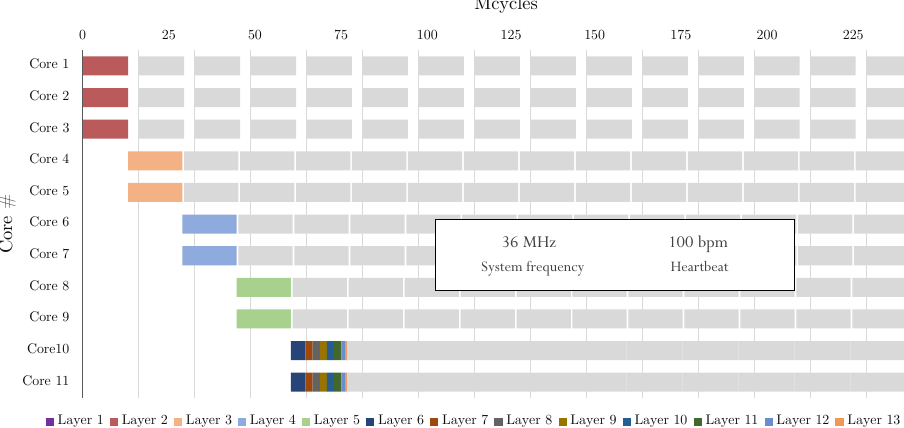
Figure 13. Dataflow on cores with a balanced pipeline and medium workload (ADAM-IF with maximum 100